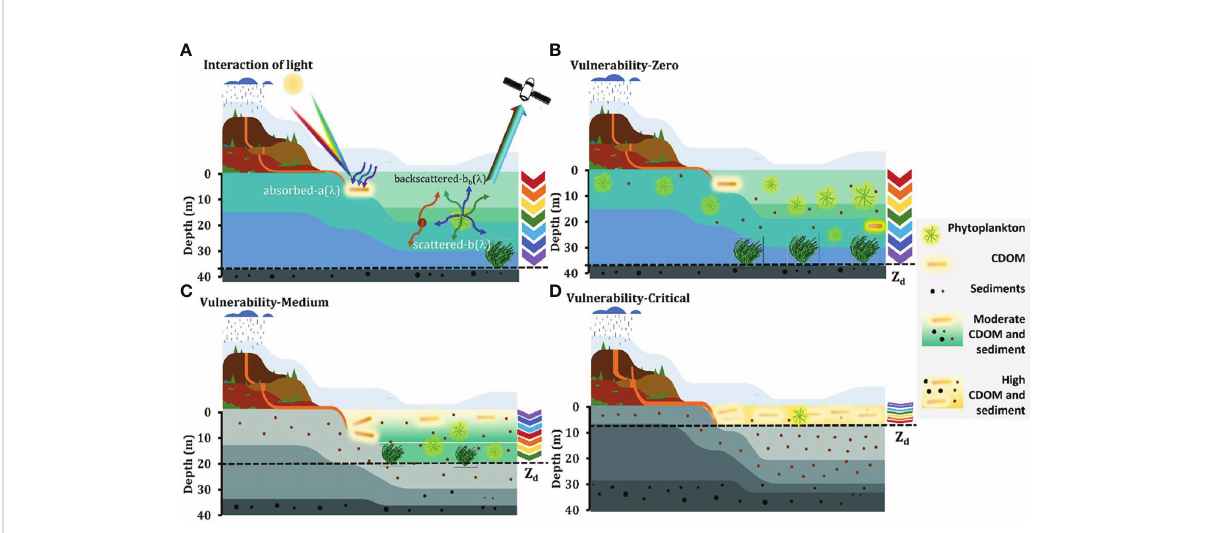
FIGURE 10 Schematic diagram of vulnerability conditions demonstrating photic zone compression and the response of photosynthetic communities to the enrichment of CDOM and sediments in the coastal water column. Panels show (A) Interaction of light in a water column, (B) low vulnerability state in naturally turbid waters, (C) medium vulnerability state in moderately high CDOM and sediment waters, and (D) critically high vulnerability state in heavily CDOM-rich and sediment-laden